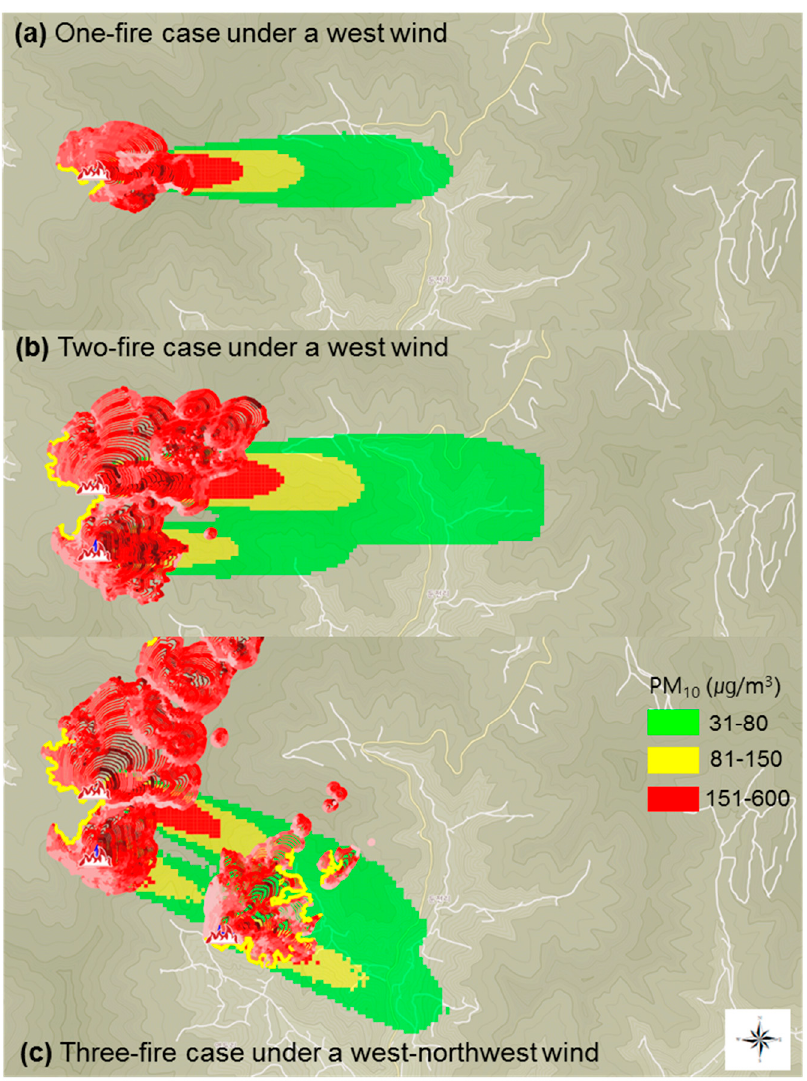
Figure 9. Effects of multiple fires on predicted dispersions of PM 10 plume concentration contours: ( a ) one-fire scenario under a west wind, ( b ) two-fire scenario under a west wind, and ( c ) three-fire case under a west-northwest wind. Both fires and predicted PM 10 surface concentrations are shown. PM 10 is coarse (<10 µm) particulate matter.